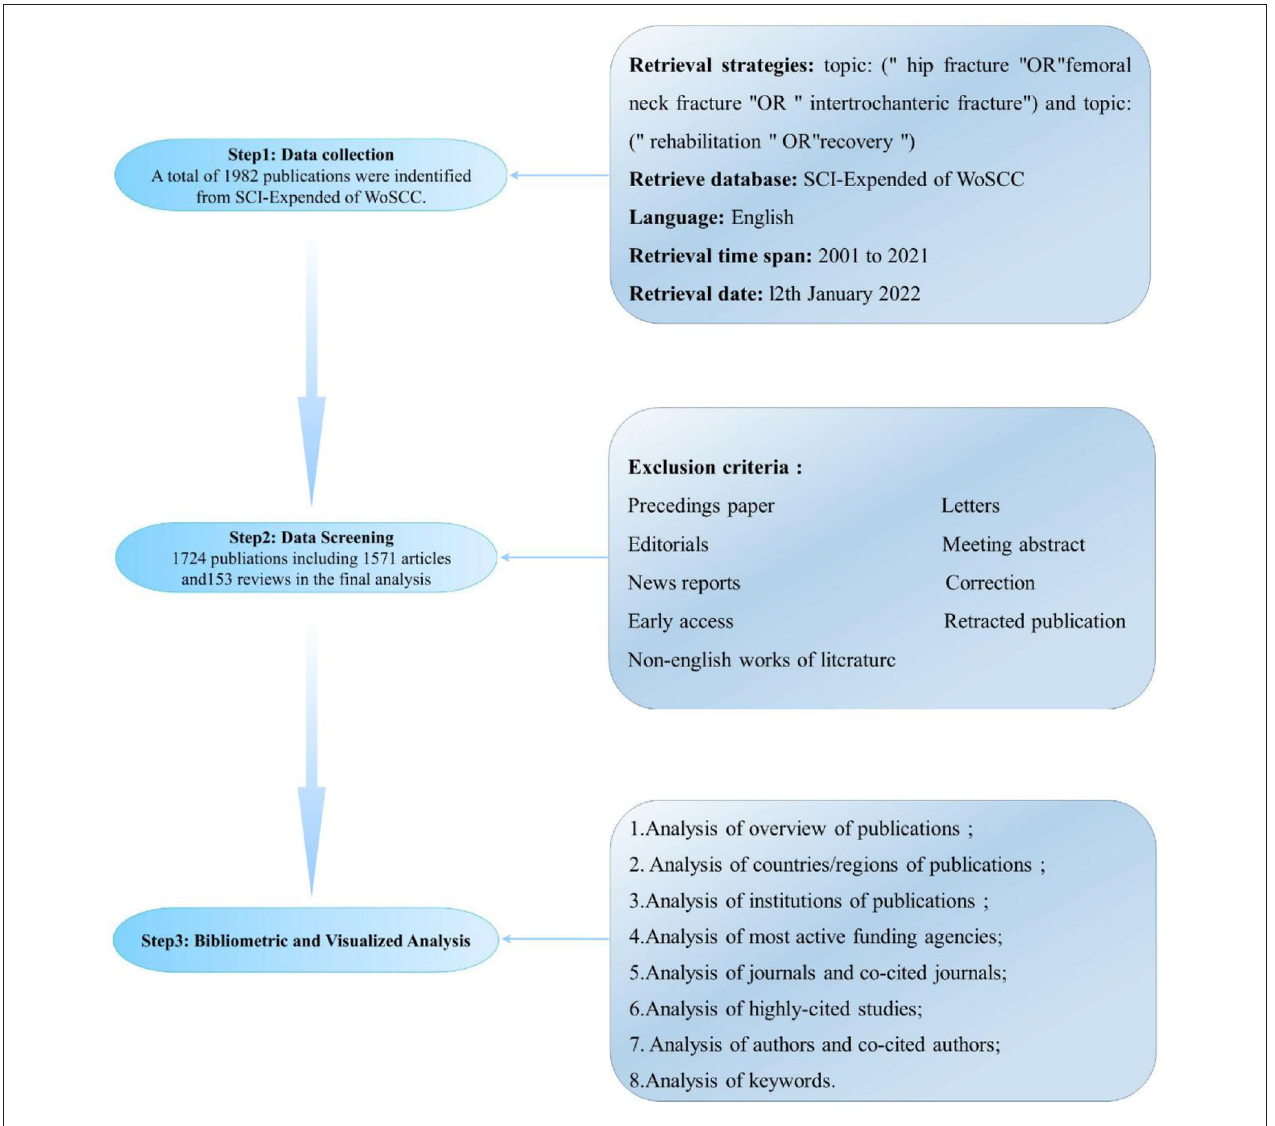
FIGURE 1 | Flowchart of literature selection and data